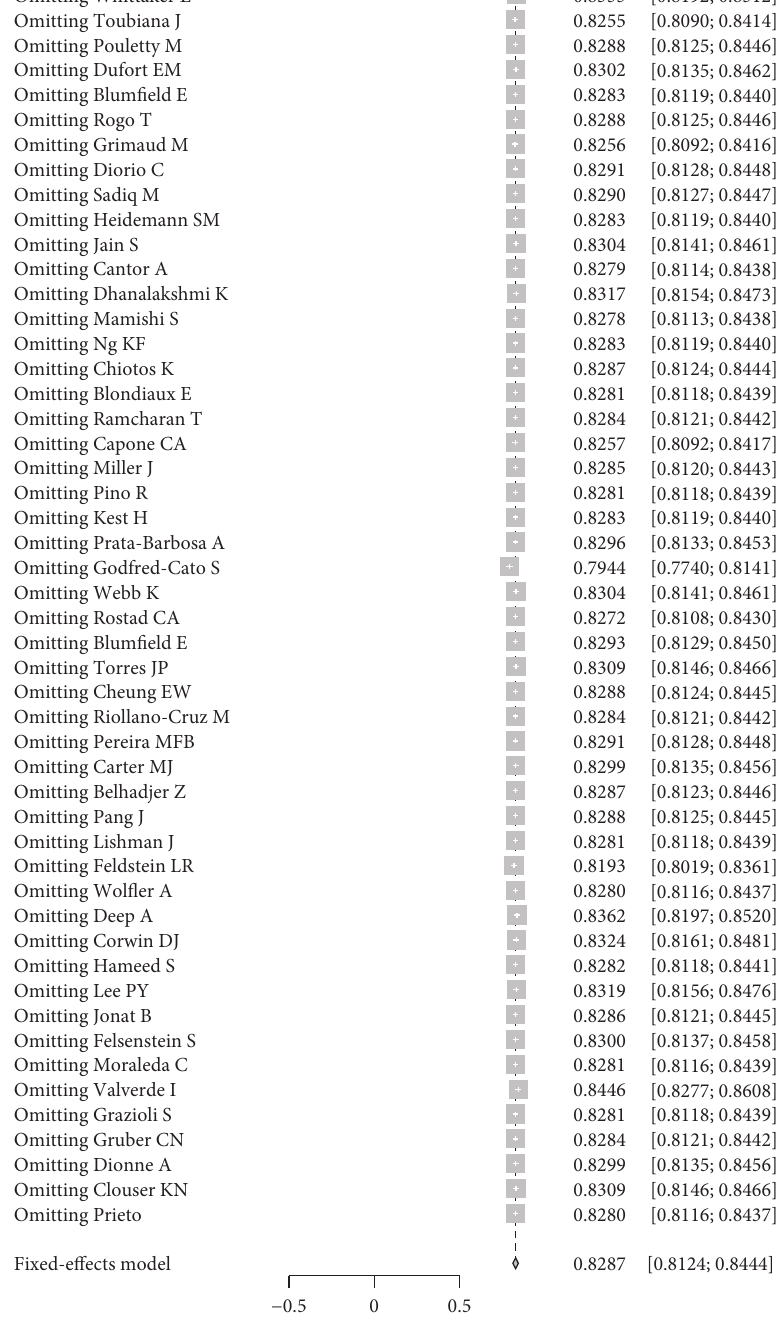
Figure 2: Sensitivity analysis of gastrointestinal